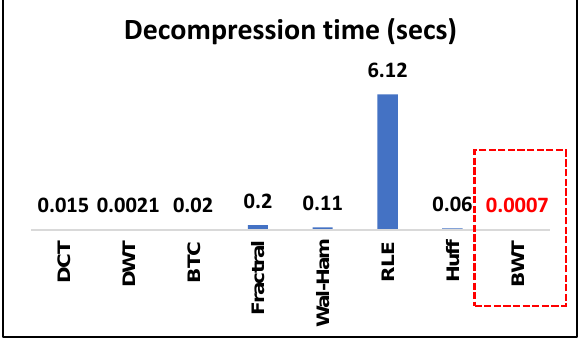
6.12 secs and Huffman Encoding takes 0.06 secs.